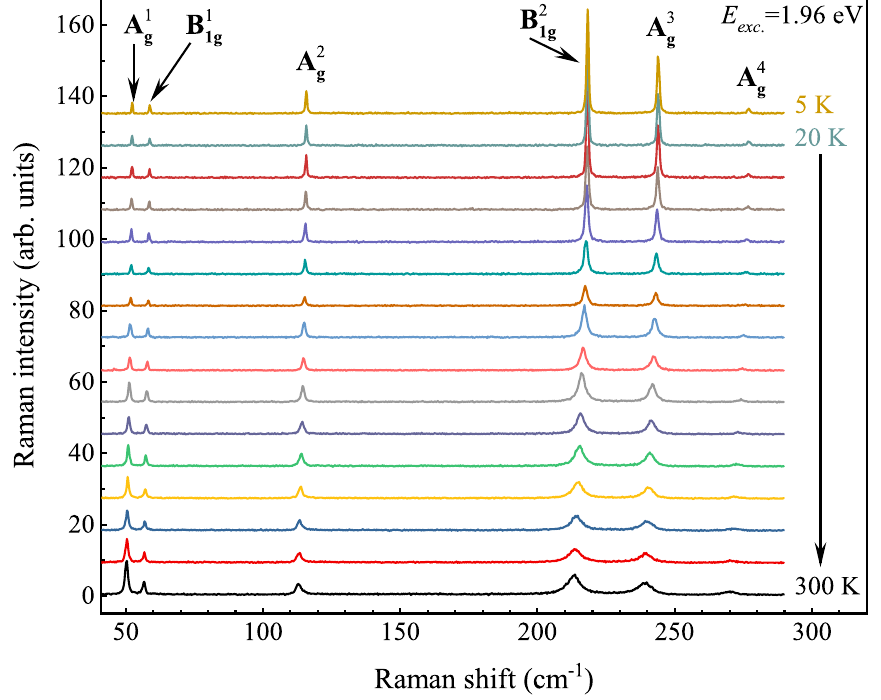
Figure A1. Raman scattering spectra measured on GeS as a function of temperature in range from 5 K to 300 K under 1.96 eV excitation.